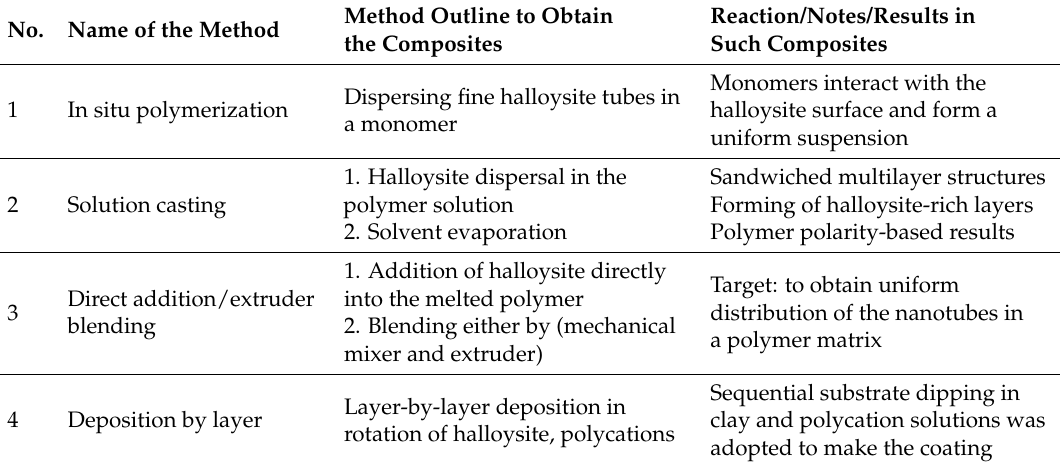
Table 2. Halloysite-polymer composites (cid:48) preparing methods